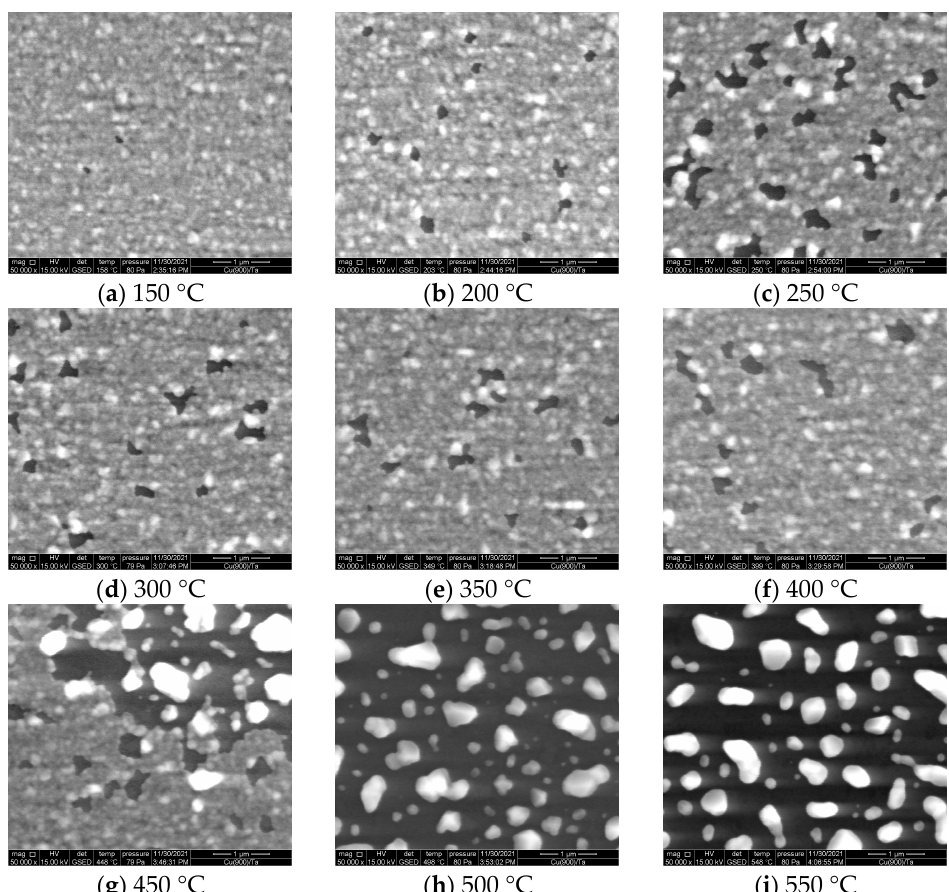
Figure 6. Surface of the Cu film deposited over a Ta layer from 150 °C ( a ) to 550 °C ( i ), using a 30 °C/min. heating rate.